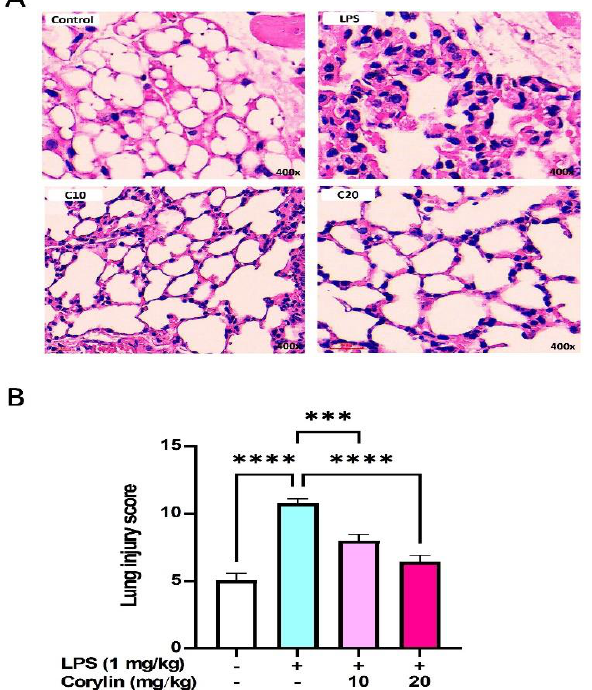
Figure 6. Effects of corylin on the lung in LPS-challenged mice. ( A ) Representative photographs of the lung tissues stained with HE. Upper left, control, the representative image PBS control. Upper right, the representative image of LPS administration. Lower left, the representative image of low dose corylin (10 mg/kg) pre-treatment following LPS administration. Lower right, the representative image of high dose corylin (20 mg/kg) pre-treatment following LPS administration. ( B ) Morphological changes in lung sections were semi-quantified using lung injury score. The results showed a pared to the LPS-induced ALI mice ( n = 4~6). The magnification is 400X. The data are shown as mean ±